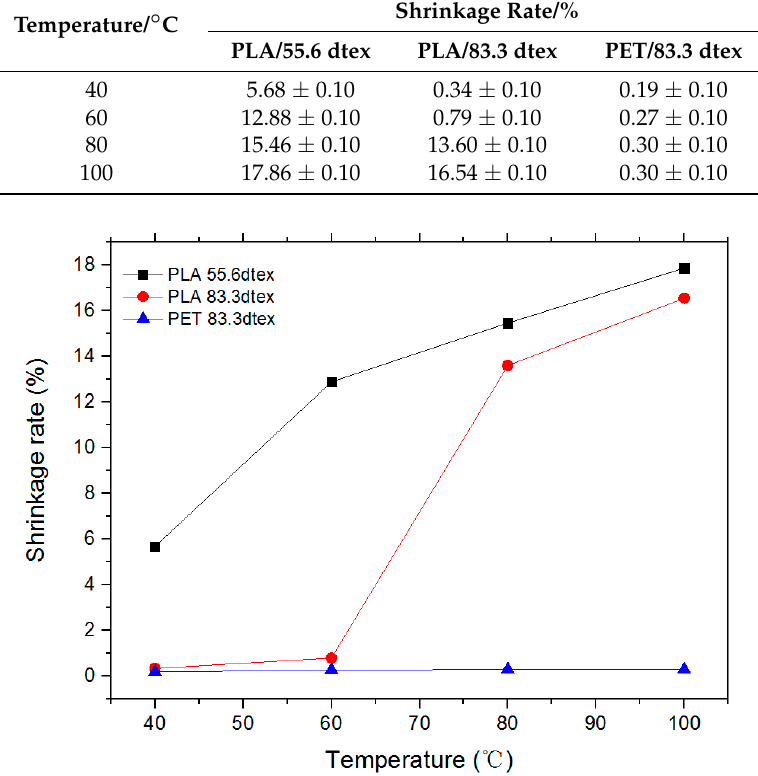
Figure 6. Thermal shrinkage diagram.